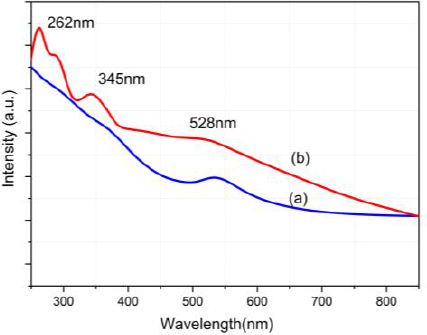
Figure 8. UV–VIS spectra of ( a ) FOA and ( b ) FOASET nanoparticles. In Figure 9A, the curves of (a) and (b), respectively, present the luminescent spectra of the FOASET nanoparticles and Eu(TTA) 3 complex under excitation at λ exc = 355 nm at room temperature. They show a red emission of the europium(III) ion with a main transition ( 5 D 0 → 7 F 2 ) λ max = 614 nm. Their luminescent mechanism was associated with an indirect excitation of the europium(III) ion (an antenna effect). The organic TTA ligand absorbs excitation energy and transfers this energy to the triplet state. From here, the energy is from 5 D 0 to the levels of the ground state of 7 F j (j = 0, 1, 2, 3, and 4). The luminescence of